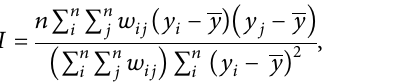
Figure 4: Schematic diagram of wayfinding task.